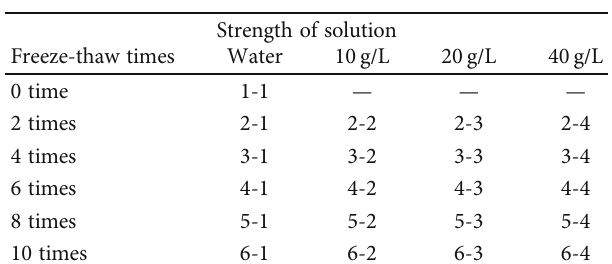
Figure 3: Test fl owchart. Table 2: Test scheme. Strength of solution